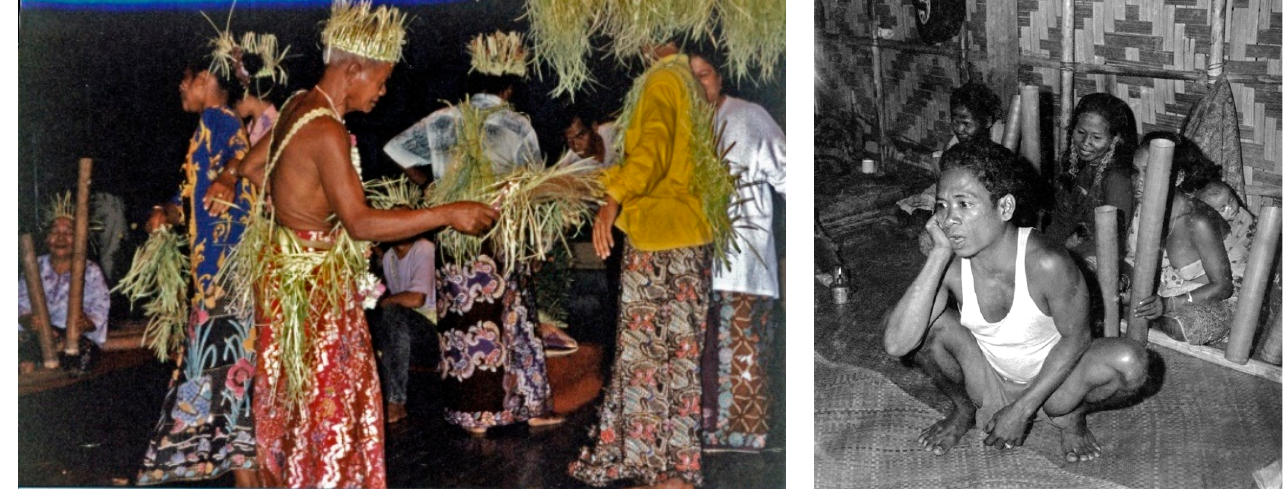
Figure 1. Temiar song performances. ( Left ) Abilem at the University of Malaya (1995); ( Right ) Salleh, Kuala Humid, Kelantan (1964).